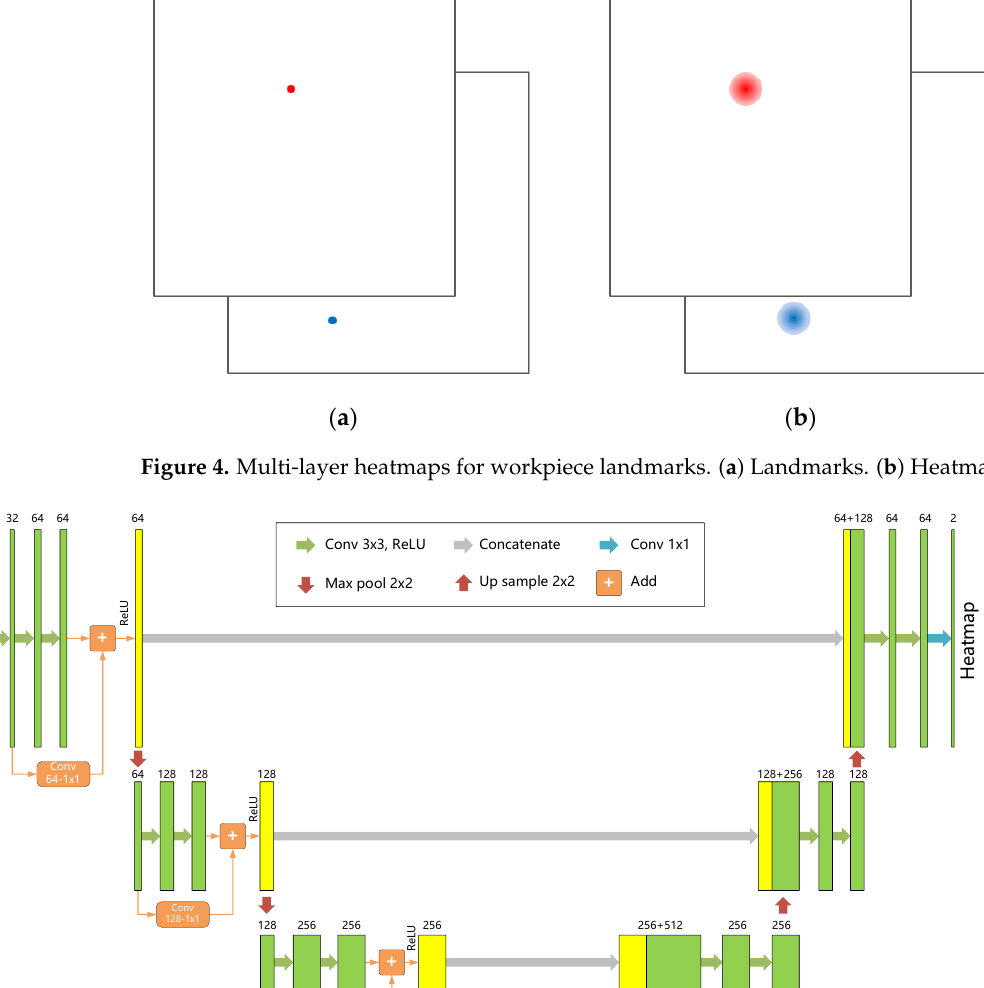
Figure 4. Multi-layer heatmaps for workpiece landmarks. ( a ) Landmarks. ( b ) Heatmaps.